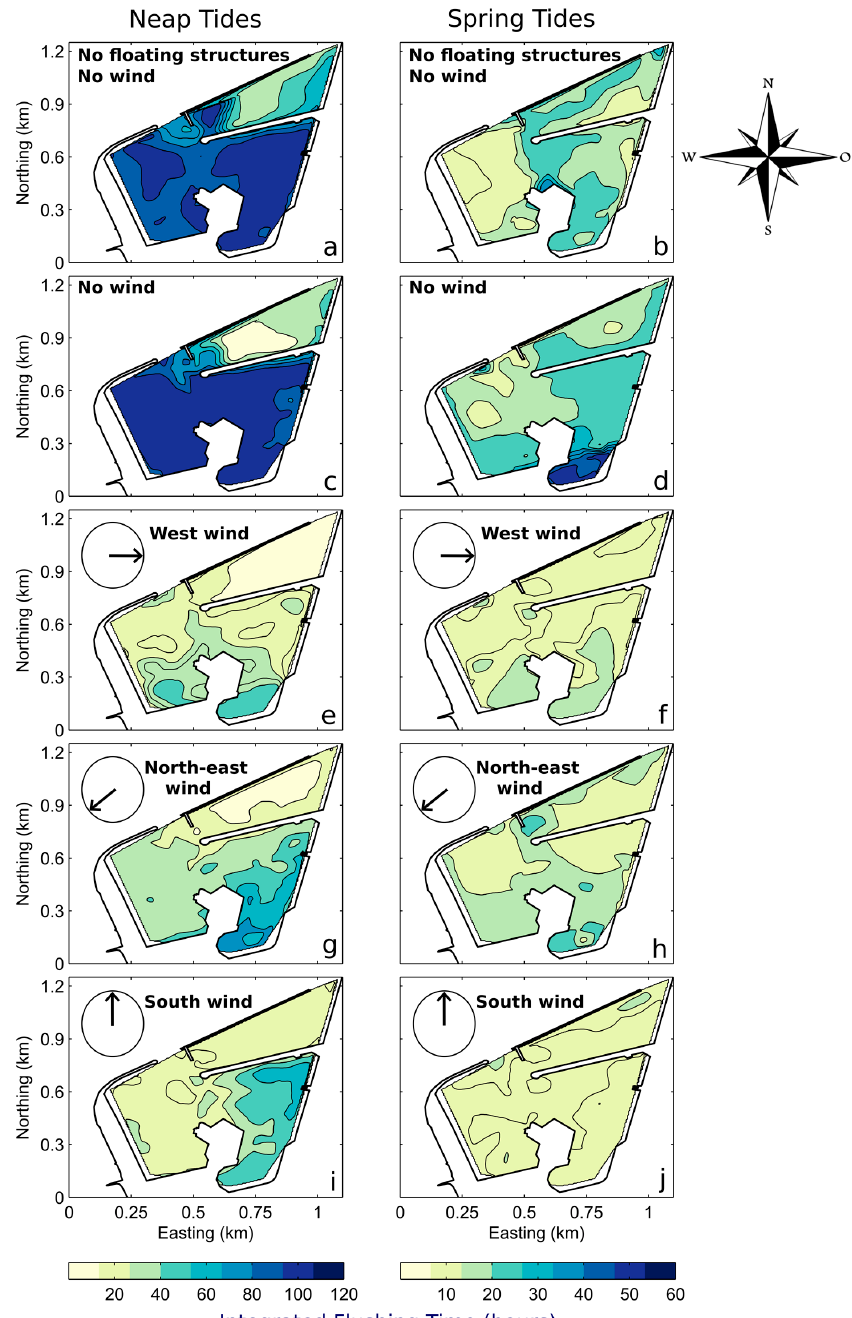
Figure 4. Spatial distribution of vertically-averaged Integrated Flushing Time (expressed in hours) within the La Rochelle marina computed for the scenario (letters) defined in Table 1. Rows characterise the wind, and FS configurations and columns correspond to the tidal regime.